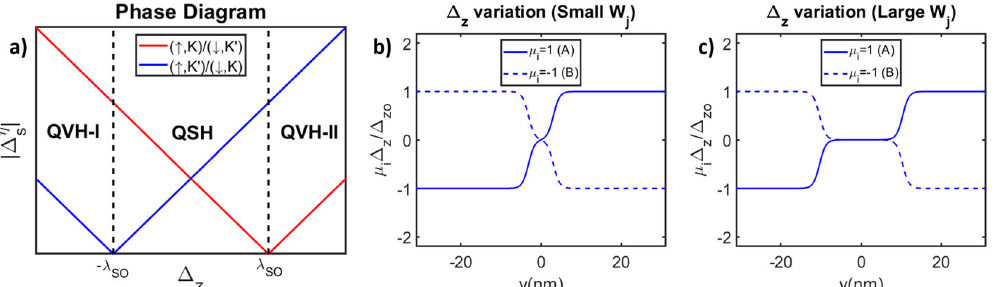
Fig. 2 Effect and variation of the sublattice potential, Δ z . a Phase diagram depicting the effect of the sublattice potential, Δ z on the Dirac j (see text). b The staggered sublattice potential, μ Δ mass, j Δ η i z variation along the y-direction in the sublattices(solid line for sublattice A and s dashed line for sublattice (B) when W j = 6.25 nm, which is small enough such that the width of the region having Δ z = 0 is negligible. c μ i Δ z variation when W j = 20.8 nm, which ensures that the width of the region having Δ z = 0 is large enough.